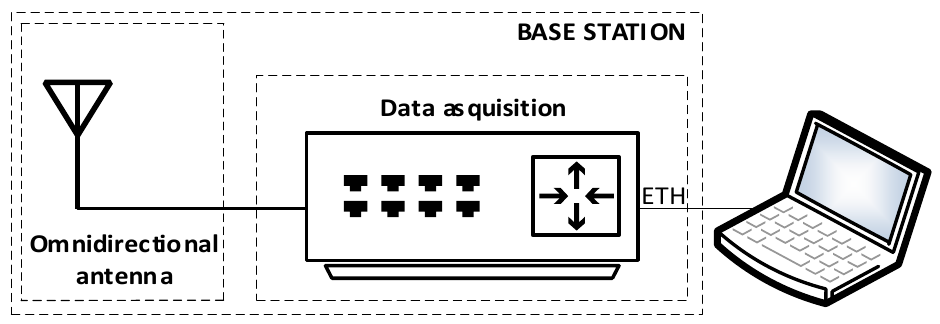
Figure 4. General diagram of the INFRA base station.